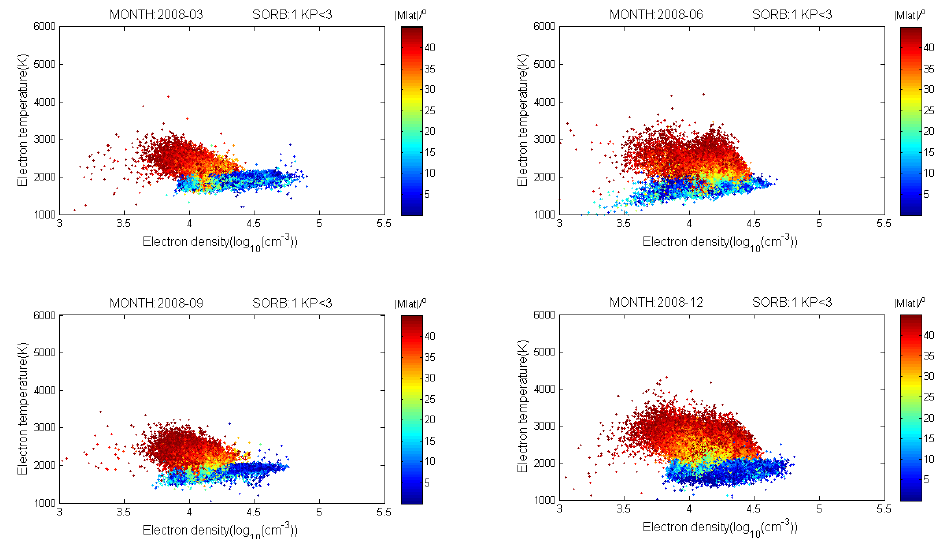
Figure 1. The distribution of log10( N e ) and T e at different magnetic latitudes (color bar) during quiet geomagnetic periods with Kp<3 during 4 months (four panels correspond to March, June, September and December) in